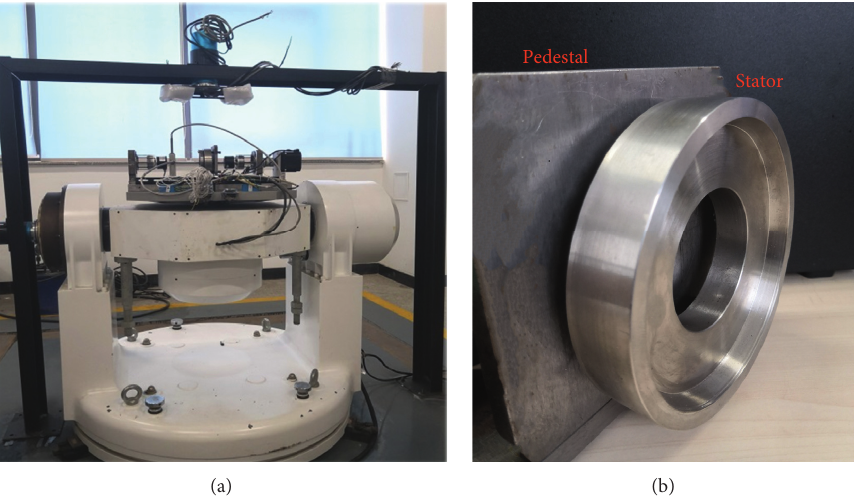
Figure 16: Transient time-frequency waterfall curves of the bending and torsional motions of the rotor system for ω (a) Bending motion and (b) torsional motion.